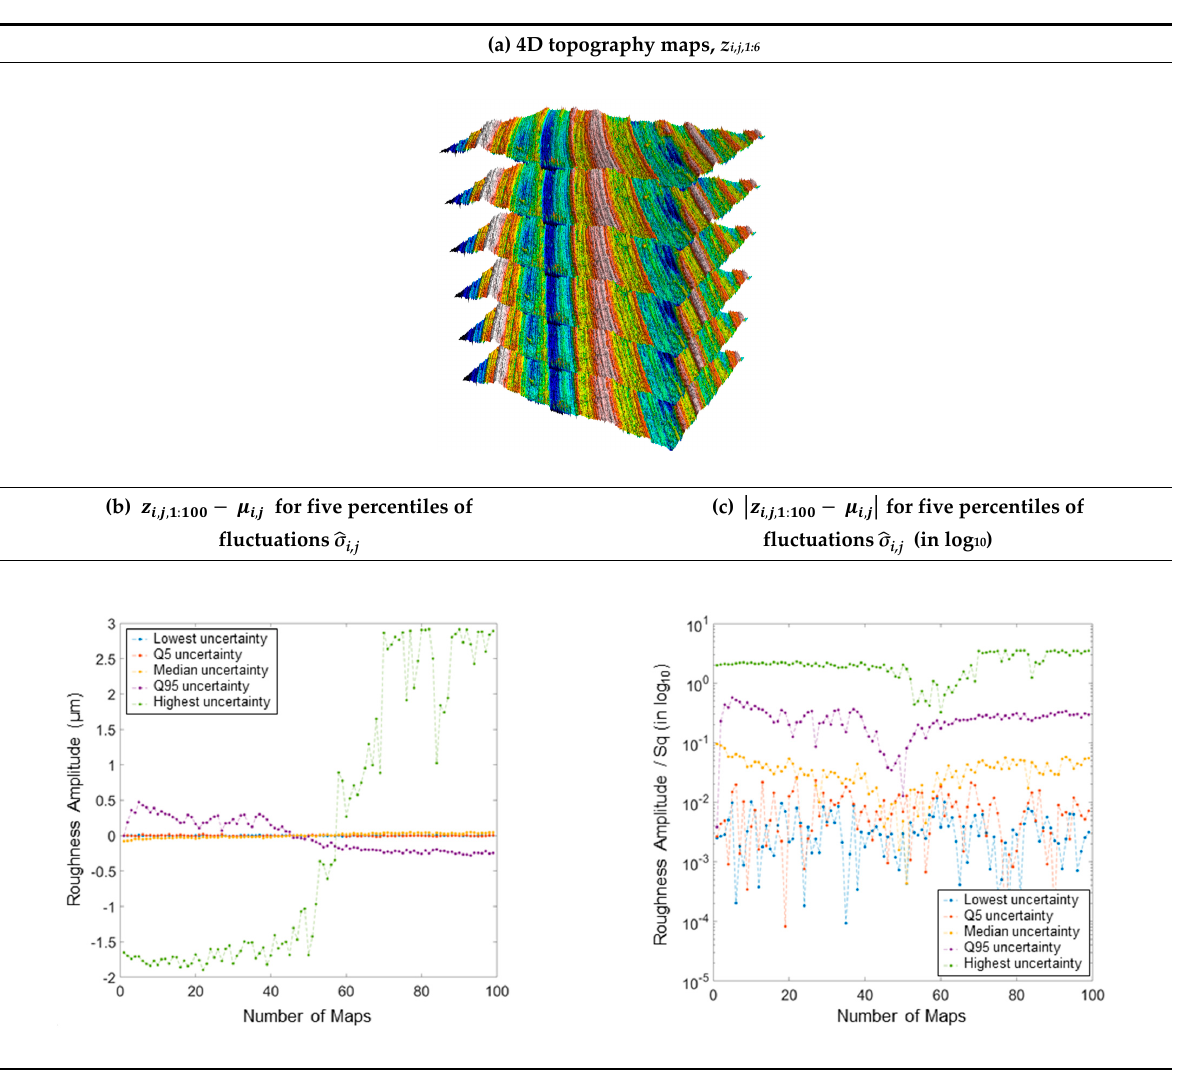
Figure 7. 3D topographies of the six elementary maps ( a ), amplitude variation during measurement ( b ), and normalized amplitude variation in log scale ( c ). The lowest, Q 5 , median, Q 95 , and highest fluctuations correspond, respectively, to the minimum, 5% lowest, median, 5% highest, and maximum fluctuations.